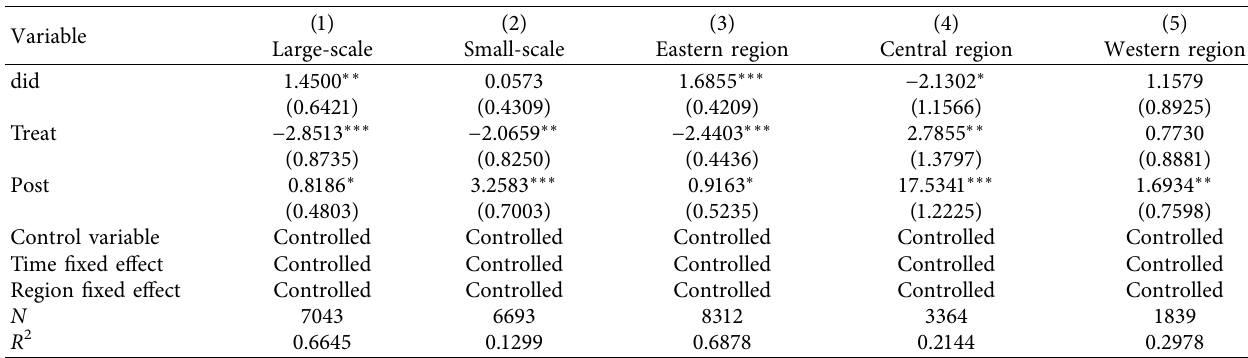
Table 5: Heterogeneity of enterprise scale and